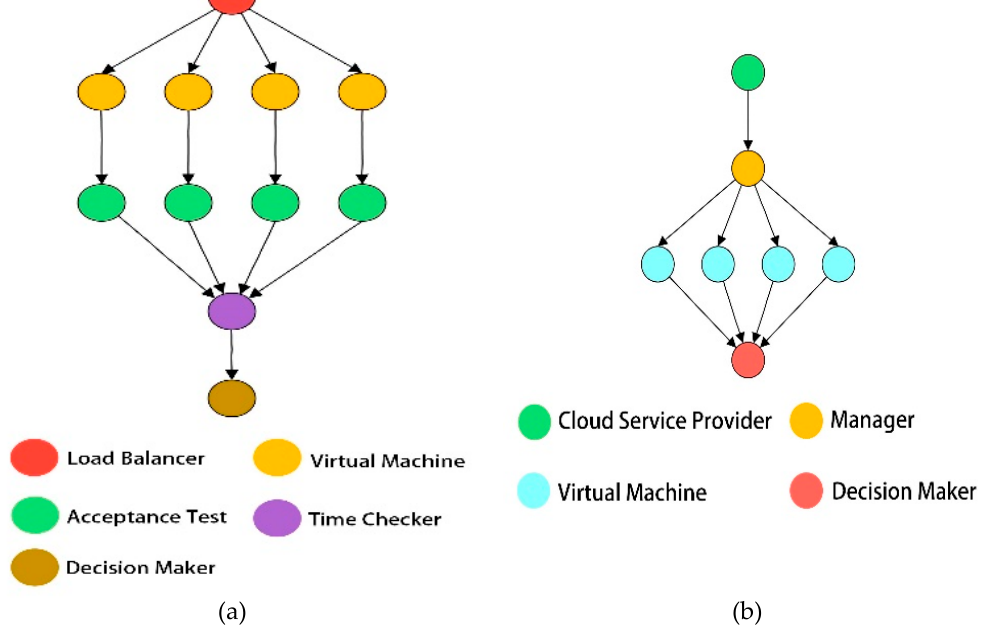
Figure 7. (a) Our proposed AFTRC workflow; (b) Our proposed VFT workflow. Figure 7. ( a ) Our proposed AFTRC workflow; ( b ) Our proposed VFT